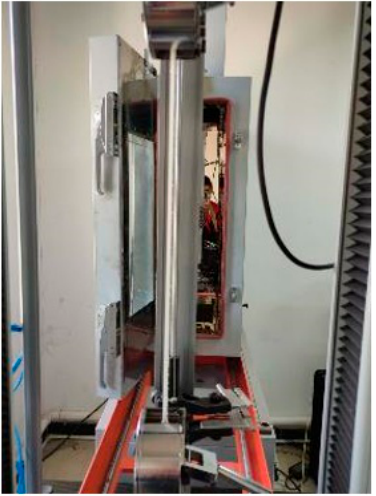
Figure 5. Image of tensile test